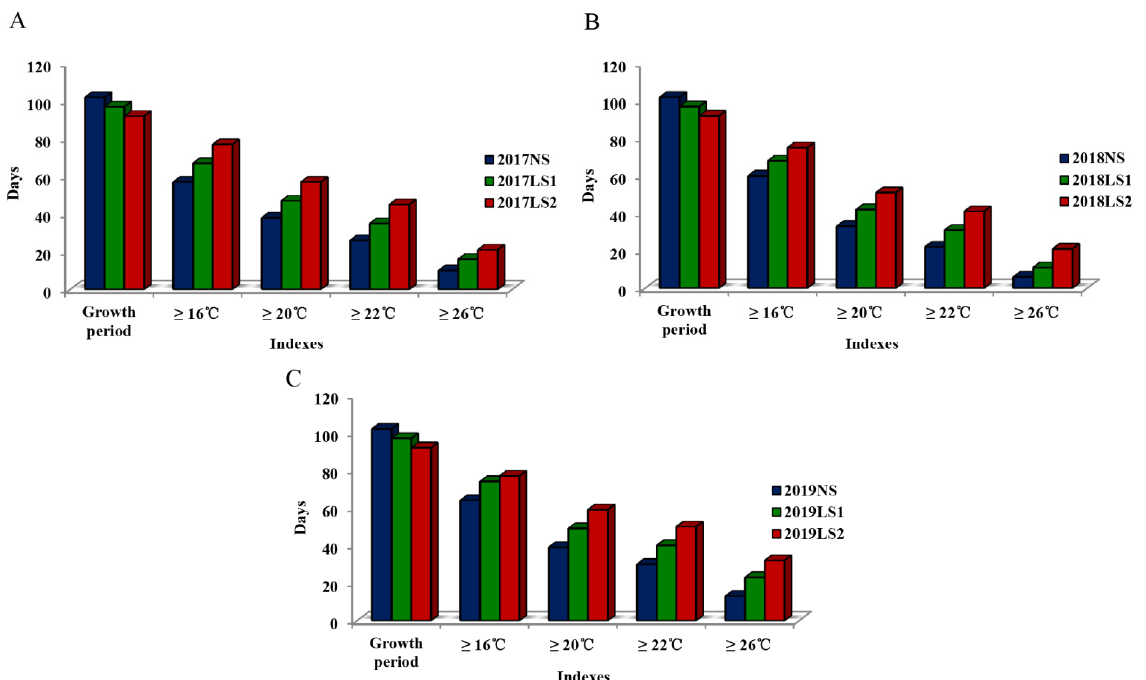
Figure 1. Comparison of daily average temperature changes in the growth periods of pea accessions at different sowing stages during the three heat-tolerance screenings.